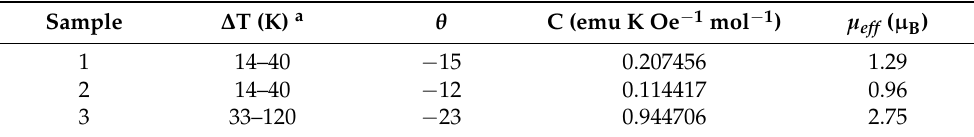
Table 1. Weiss temperature ( θ ), Curie constant (C), and the effective magnetic moments ( µ ef f ) for Sample 1, Sample 2, and Sample